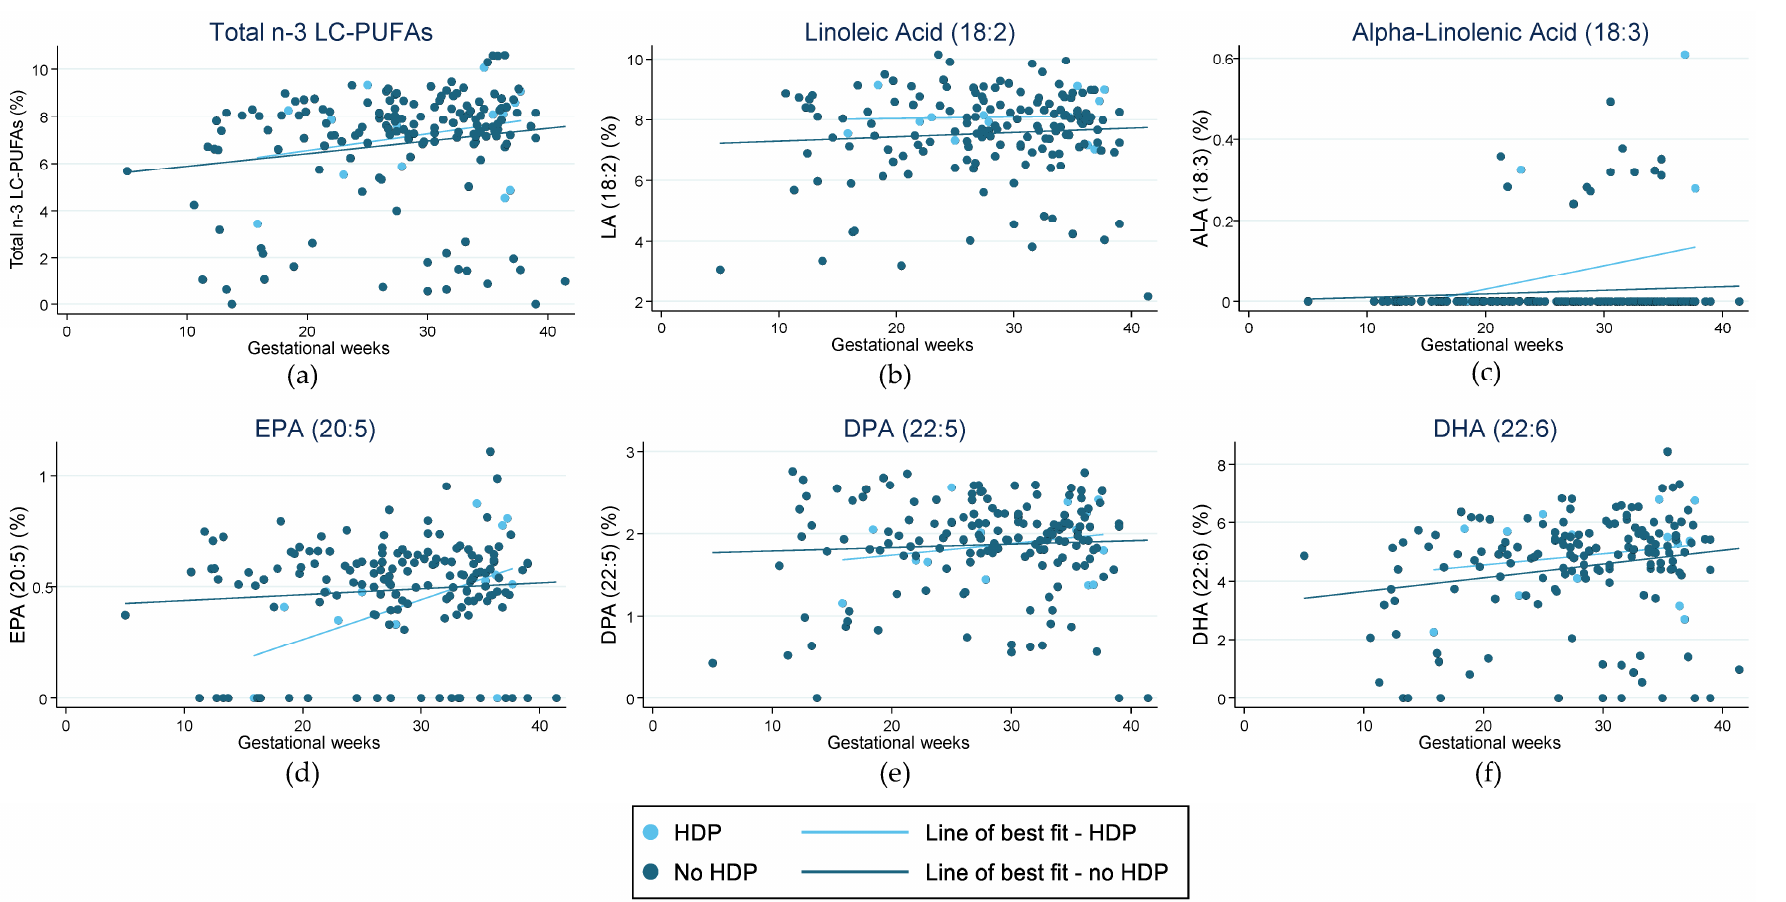
Figure 2. Fraction of LC-PUFAs (long-chain polyunsaturated fatty acids) in red blood cell membranes in pregnant women from the Gomeroi Gaaynggal cohort and those who experienced hypertension during pregnancy (HDP): ( a ) Fraction of total n -3 LC-PUFAs (Omega-3 long-chain polyunsaturated fatty acids) (EPA, DPA and DHA); ( b ) Fraction of linoleic acid (18:2); ( c ) Fraction of alpha-linolenic acid (18:3); ( d ) Fraction of EPA (eicosapentaenoic acid) (20:5); ( e ) Fraction of DPA (docosapentaenoic acid) (22:5); ( f ) Fraction of DHA (docosahexaenoic acid) (22:6).